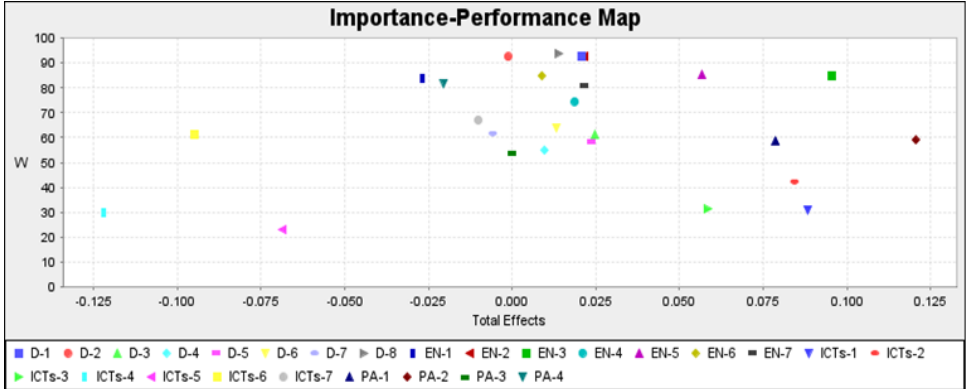
Figure 3. Representation of each life habit assessed in the ENHASA questionnaire (see Table 3). Importance ‐ performance map of latent variables to weight.